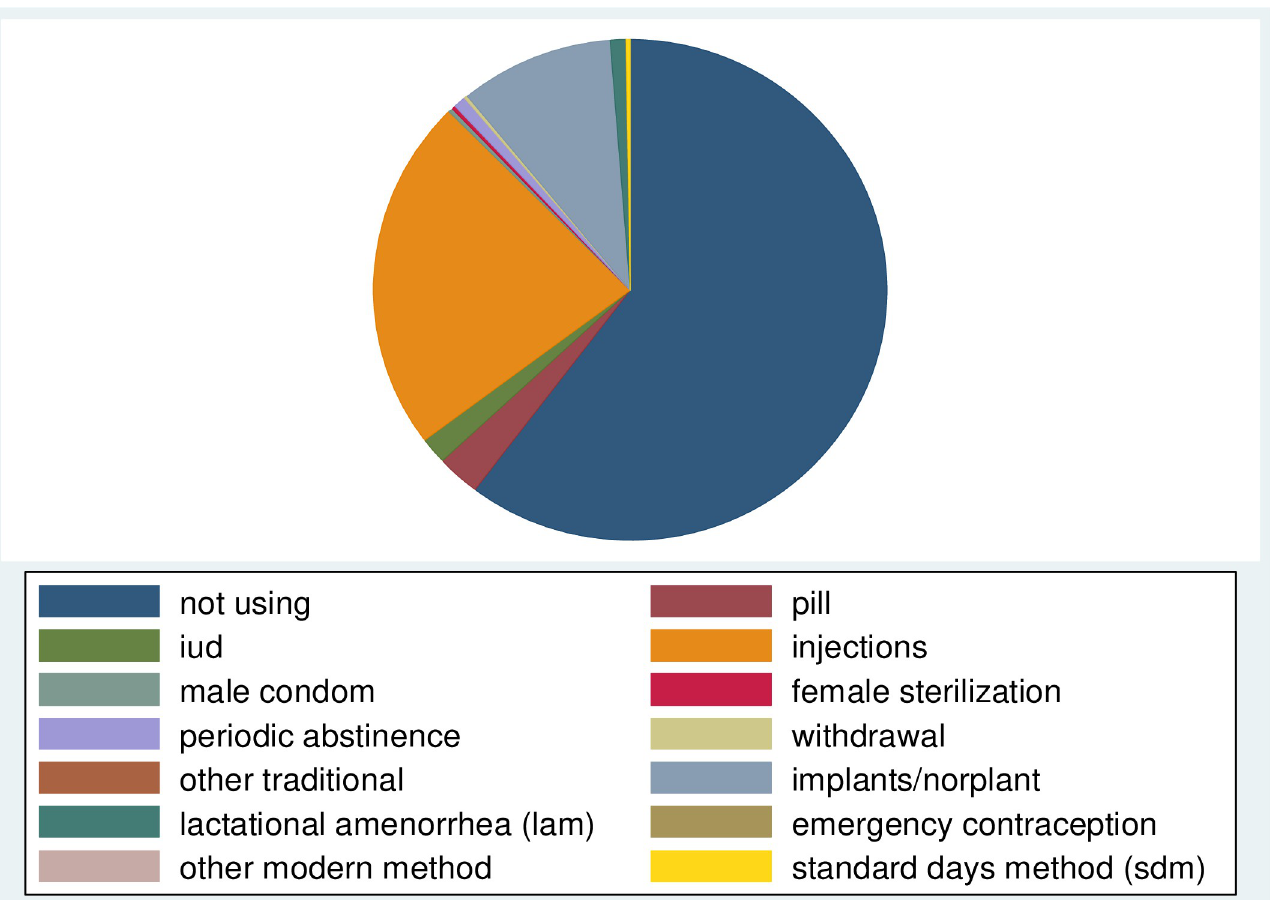
Fig 2. Proportion of current use by contraceptive method among married women in Ethiopia, EMDHS 2019.